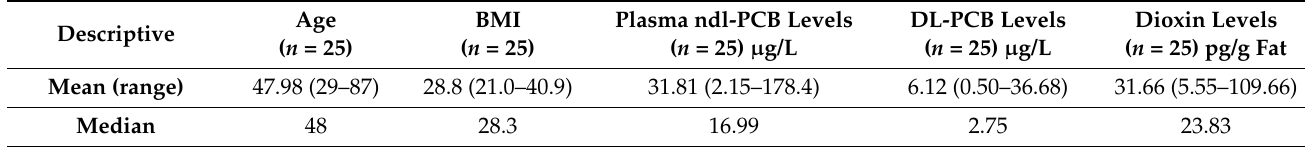
Table 1. Descriptive statistics of the